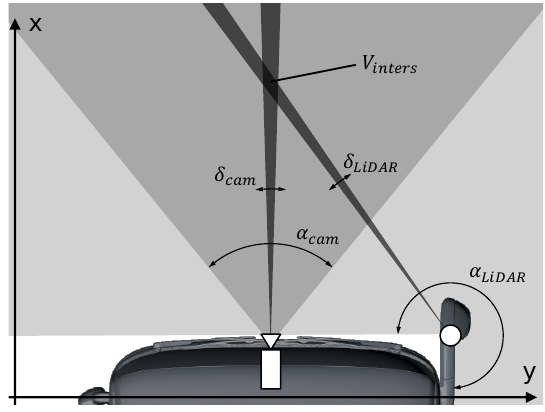
Figure 1a. Top-down view of an exemplary sensor setup at the test vehicle’s front for low-level data fusion of camera (center) and LiDAR (right, at the mirror). The measuring area of the respective sensor is highlighted and their FOV is marked by an arrow.